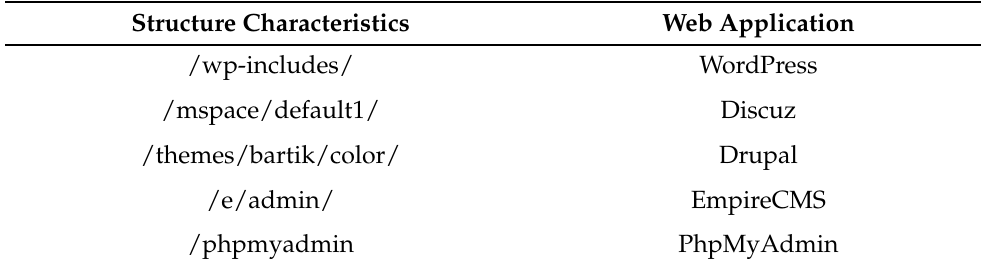
Table 4. Directory characteristics of Web